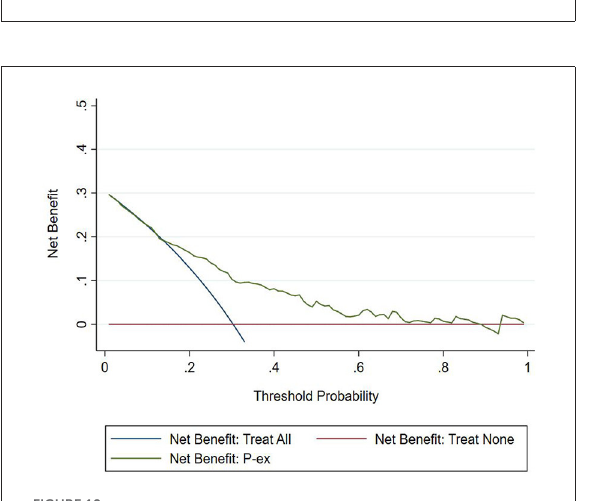
FIGURE10 DCA of external verification